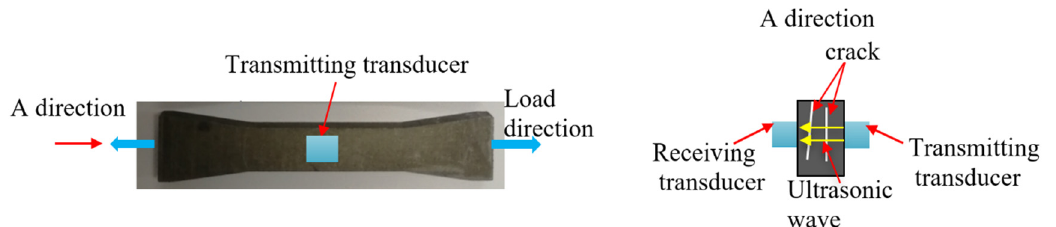
Figure 14. A schematic diagram of the ultrasonic propagation direction and crack direction.